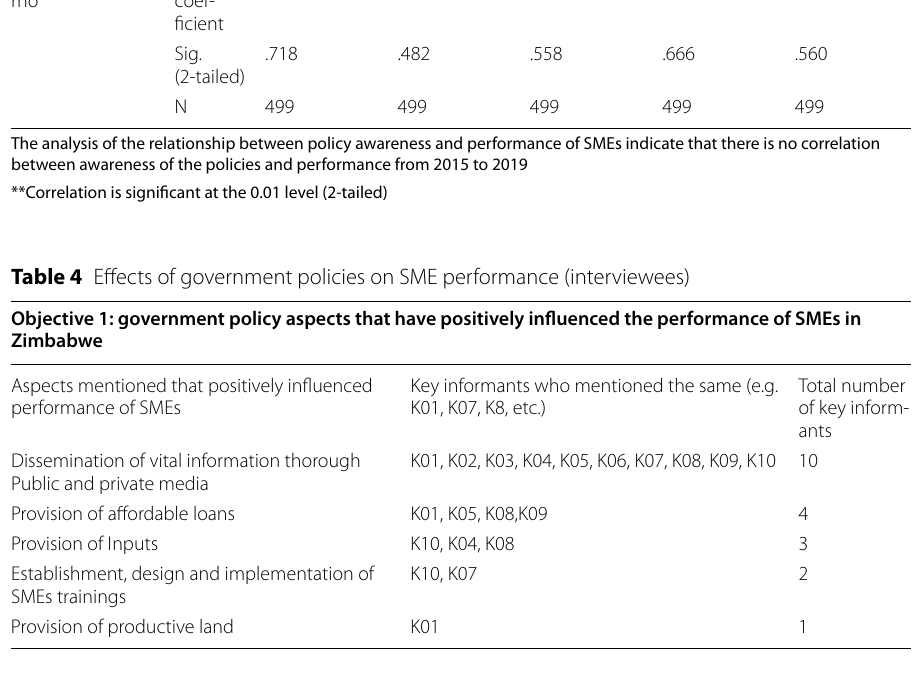
Table 3 Analysis of the relationship between policy awareness and performance of SMEs